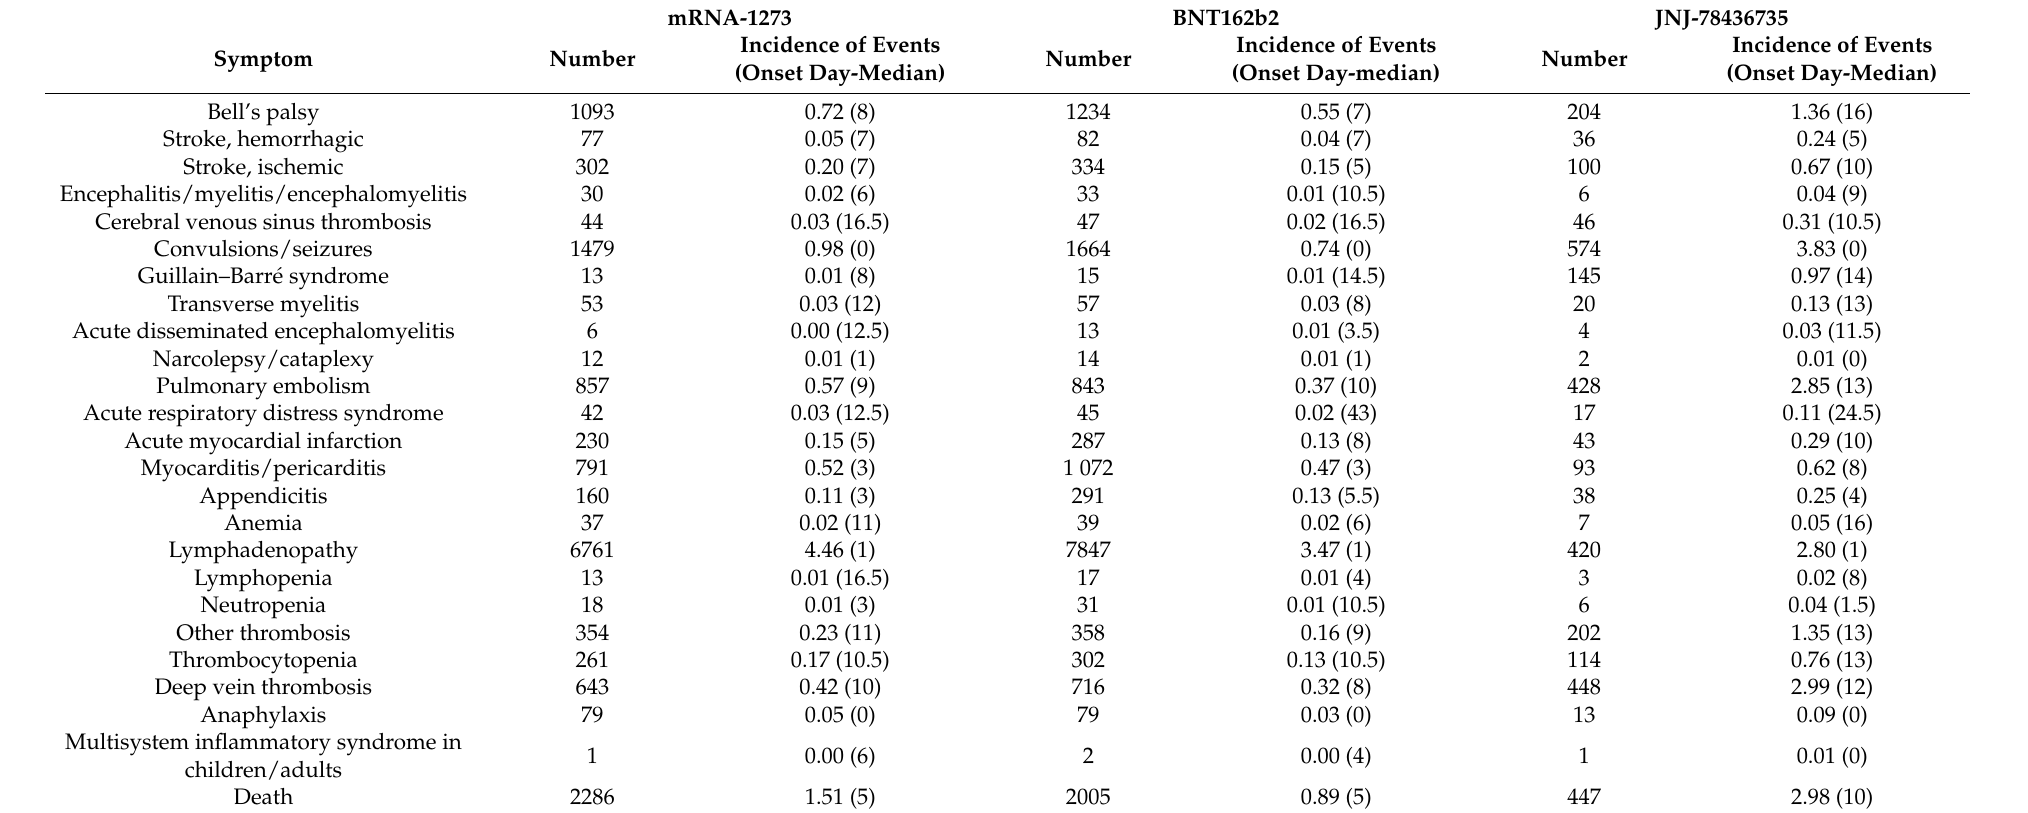
Table 2. Incidence (per 100,000 people) of 25 severe AEs with onset days after